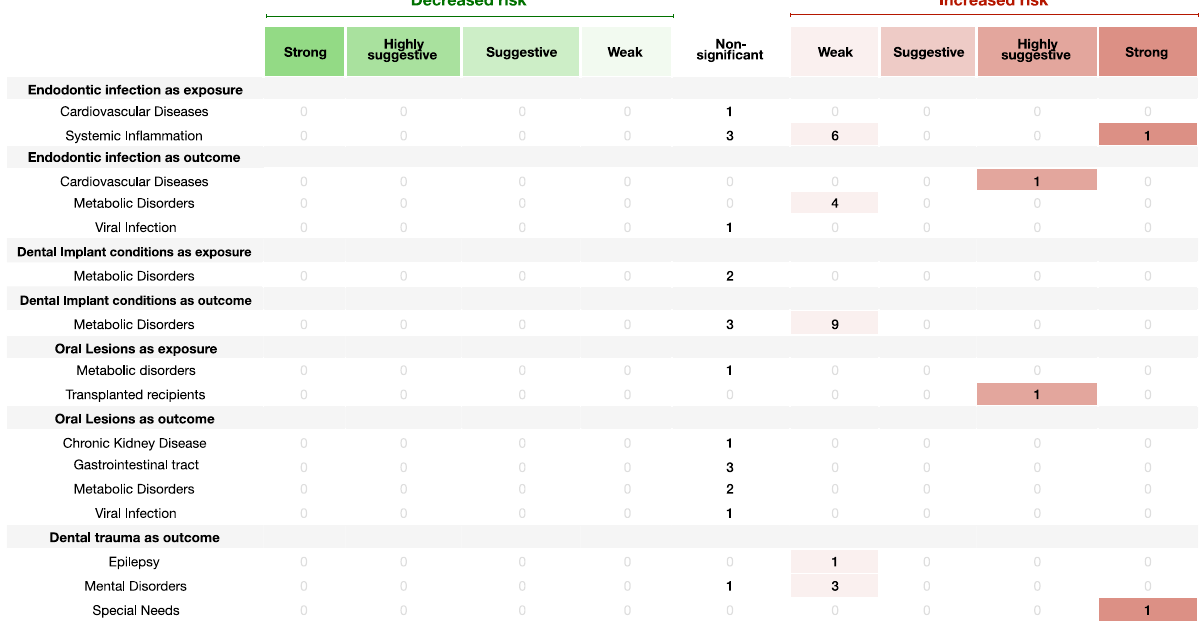
red), whereas the left side shows associations that reduce the risk (in green). APO adverse pregnancy outcomes, CVDs cardiovascular diseases, CKD chronic kidney disease, Dis. disease. Source data are provided as a Source Data fi le.